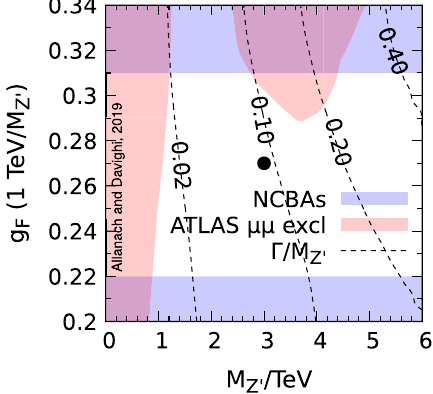
haszeroelectriccharge. R